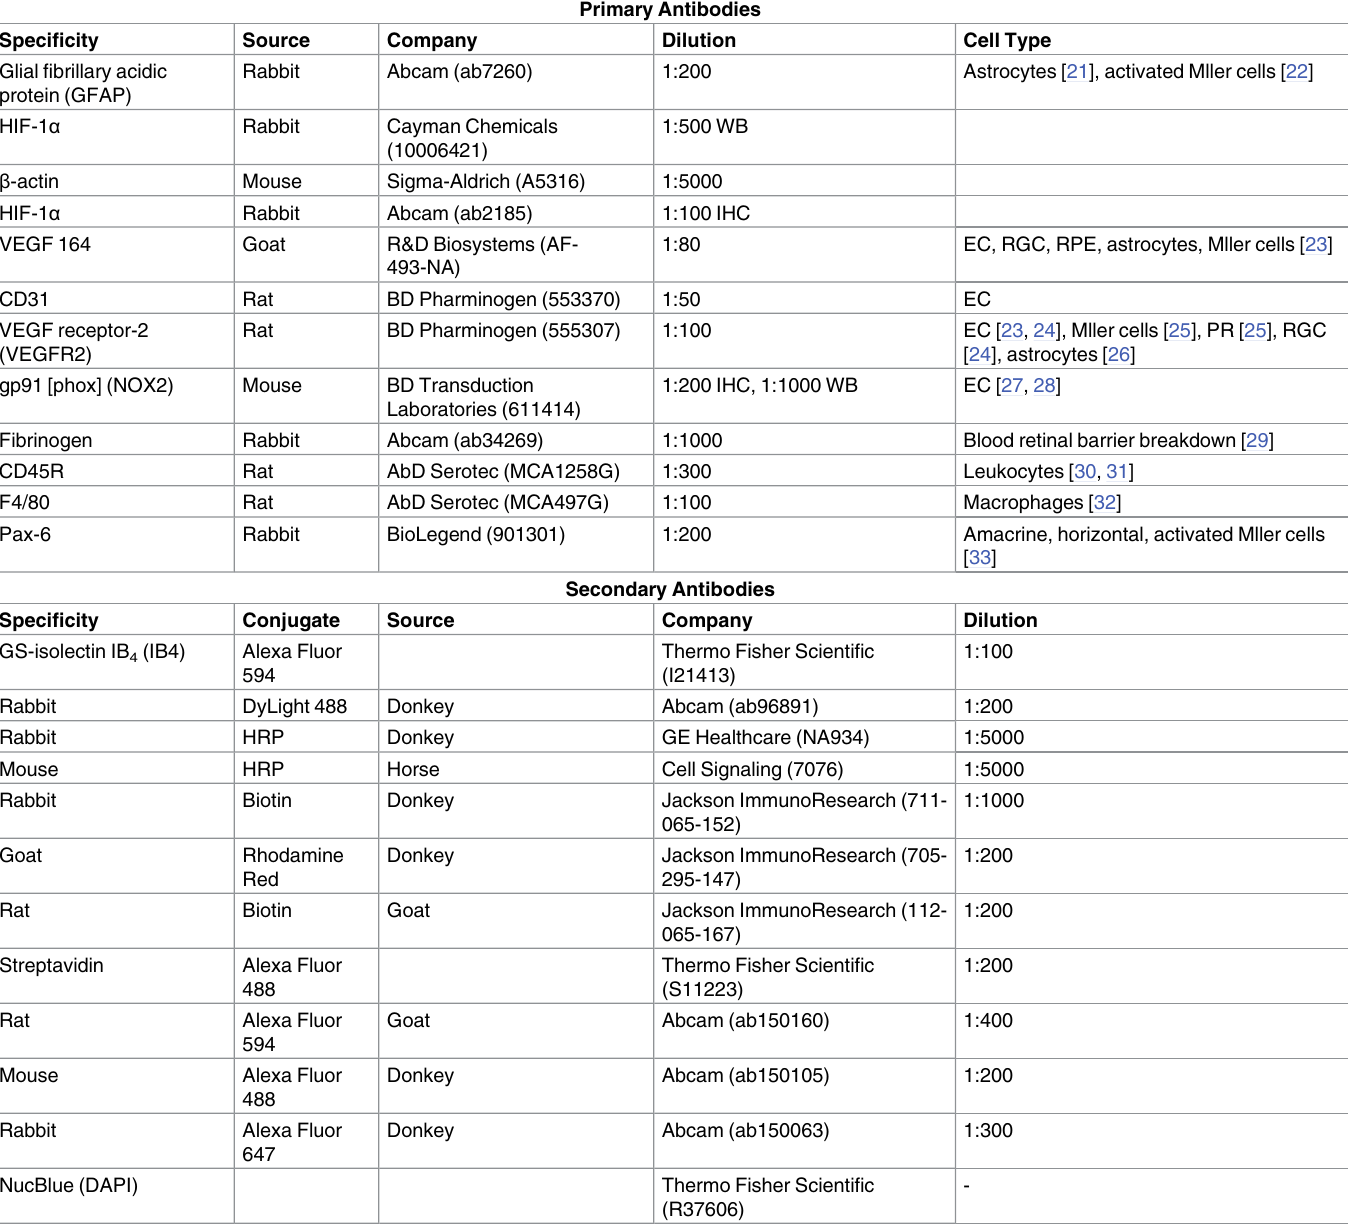
Table 1. List of antibodies used for immunohistochemistry and western blotting.